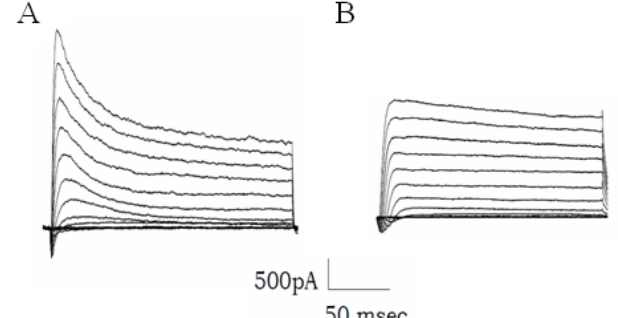
Figure 5. Expression of 38B eliminates fast inactivation of outward K + current. Traces were obtained from a control neuron ( A ) and from a neuron transfected with 38B ncRNA ( B ). Current were evoked by 200 ms long voltage steps from –50 mV to +50 mV in 10 mV increments, after a prepulse at –100mV, starting from a holding potential of –100